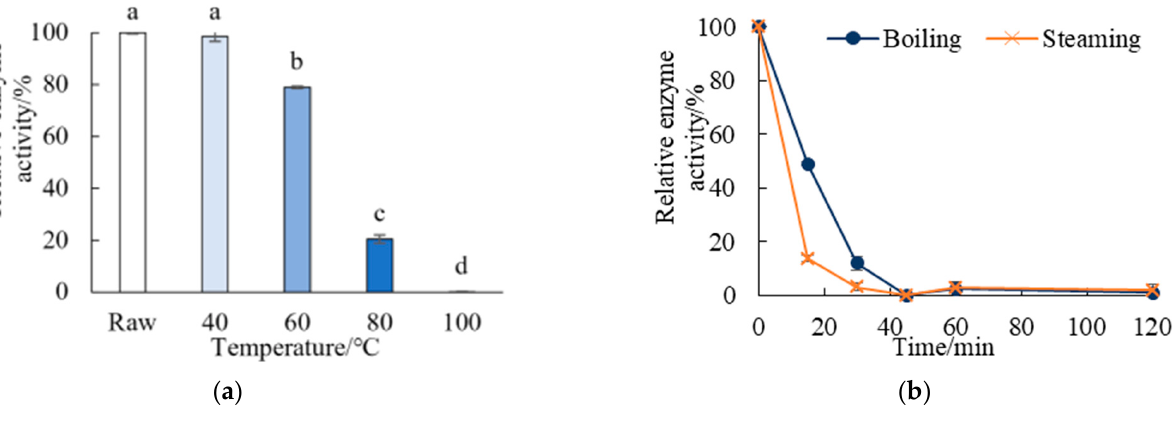
Figure 6. Relative enzyme activity of C. frondosa after various heat treatments, ( a ) comparison of relative enzyme activity during cooking for 45 min at different temperatures (40, 60, 80, and 100 °C), and ( b ) comparison of relative enzyme activity after boiling and steaming at 100 °C for 0–120 min. Different letters (a, b, c, d, e) indicate significant differences between groups as determined via one-way ANOVA ( p < 0.05).